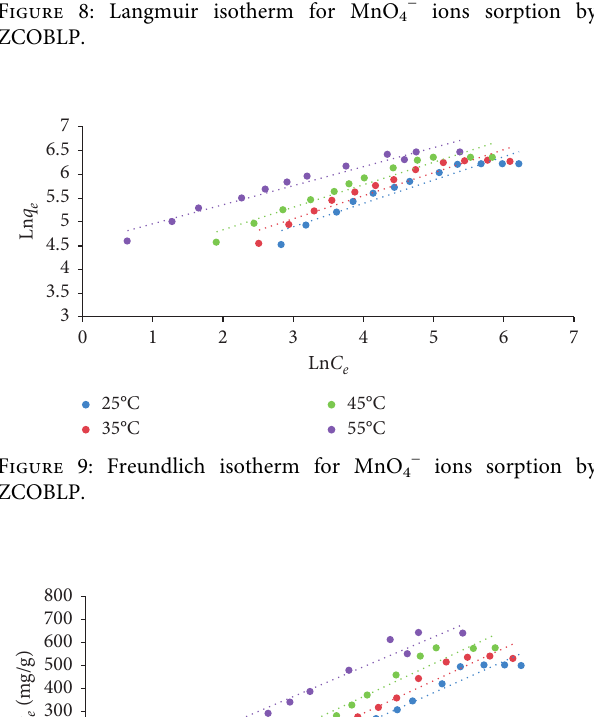
− ions sorption by 4